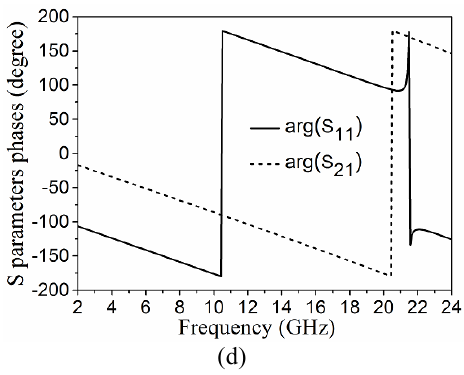
Figure 2: Scattering parameters response of the unit cell metamaterial, (a) Magnitude response for m =4 mm, (b) phase response for m =4 mm, (c) Magnitude response for m =1.1 mm, and (d) phase response for m =1.1 mm.